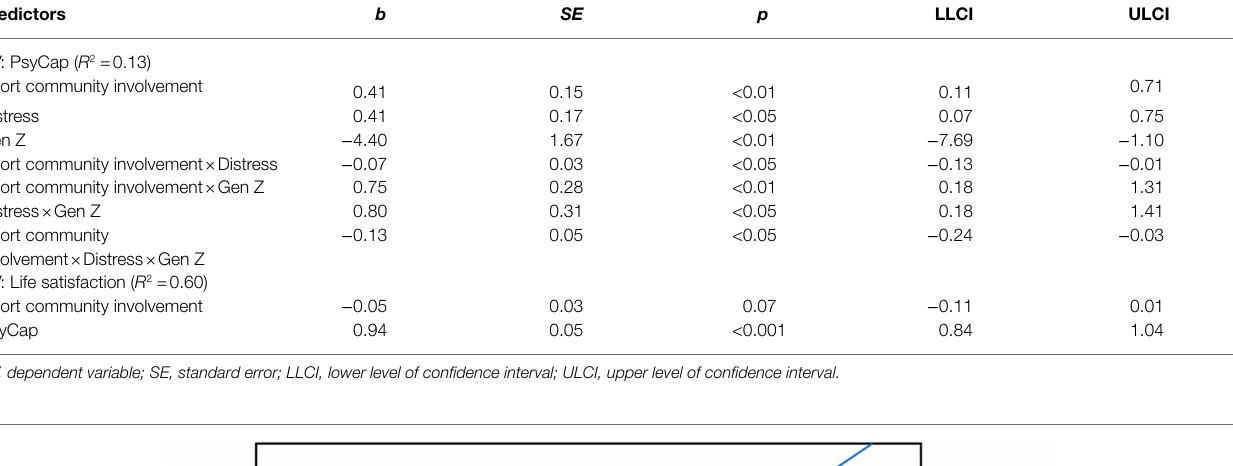
TABLE 2 | Path estimates. Predictors